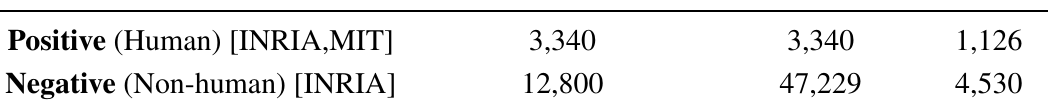
Table 5. Data sets used for support vector machine (SVM) classifier training.